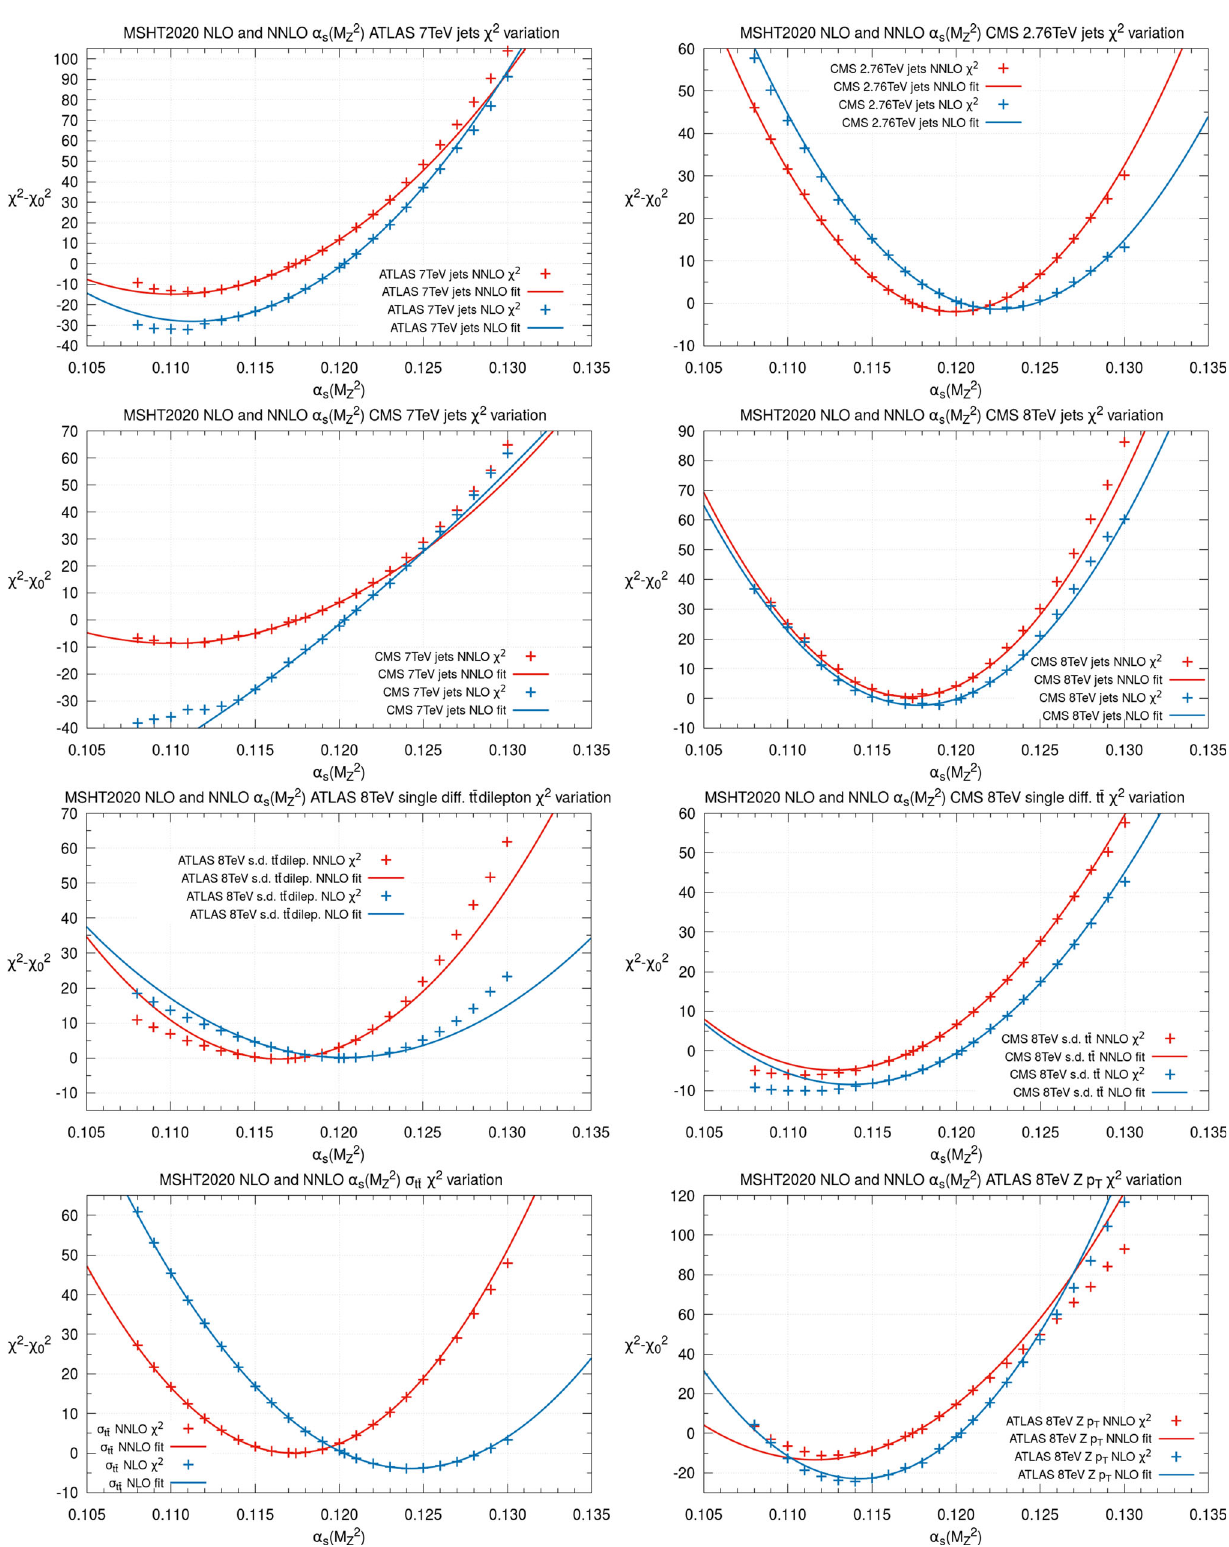
) values, whilst the curves are quadratic Z ) areshown,i.e.jet, t ¯ t and Z p Z